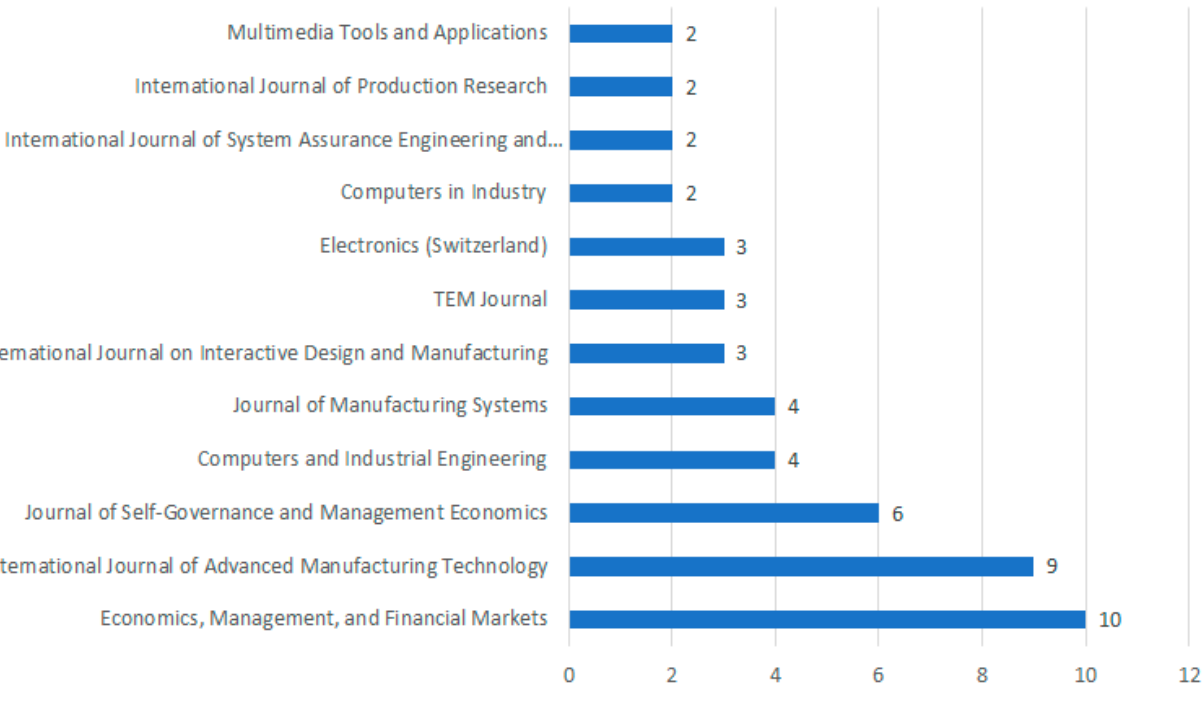
Figure 21. A number of papers in each investigated journal (for journals with at least two published papers from the analyzed 214 articles).